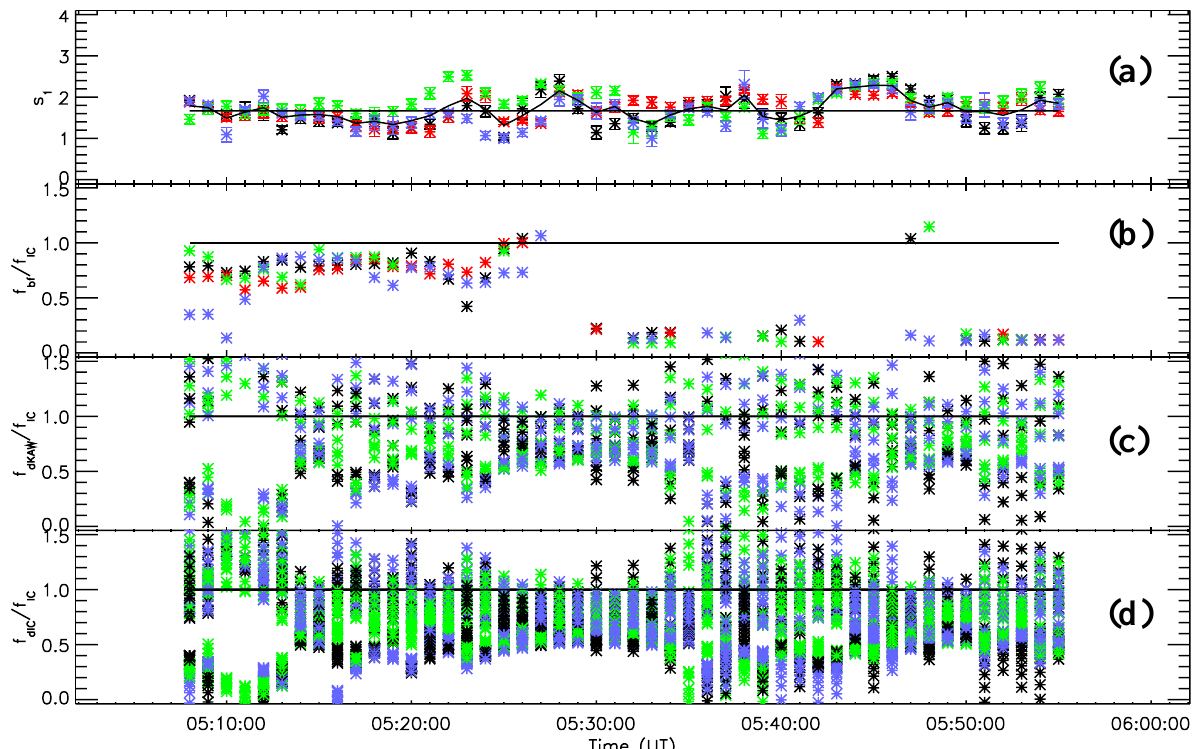
Fig. 13. (a) The inertial range slopes calculated every minute using a 8192-point window with FGM data. (b) The ratio of the observed spectral breakpoint frequency f bf to f IC for the same spectra as calculated for panel (a). The empty points indicate that the break point was not clearly identifiable. Panels (c)–(d) show the ratio of the Doppler shifted theoretical spectral breakpoint frequency to f IC (at B =85nT): (c) shows the kinetic Alfv´en wave solutions with values of k ⊥ , k k , θ kB listed in Table 2 (d) shows the IC wave solutions according to Table 4. Note that the Doppler shift for each solution is calculated both for θ kB and θ kB + 180 ◦ . The colors correspond to different spacecraft and the Doppler shift is not calculated for sc2 due to lack of plasma data. The calculation of the Doppler-shift uses 11.4-s averages of variables V and θ kV in Eq.